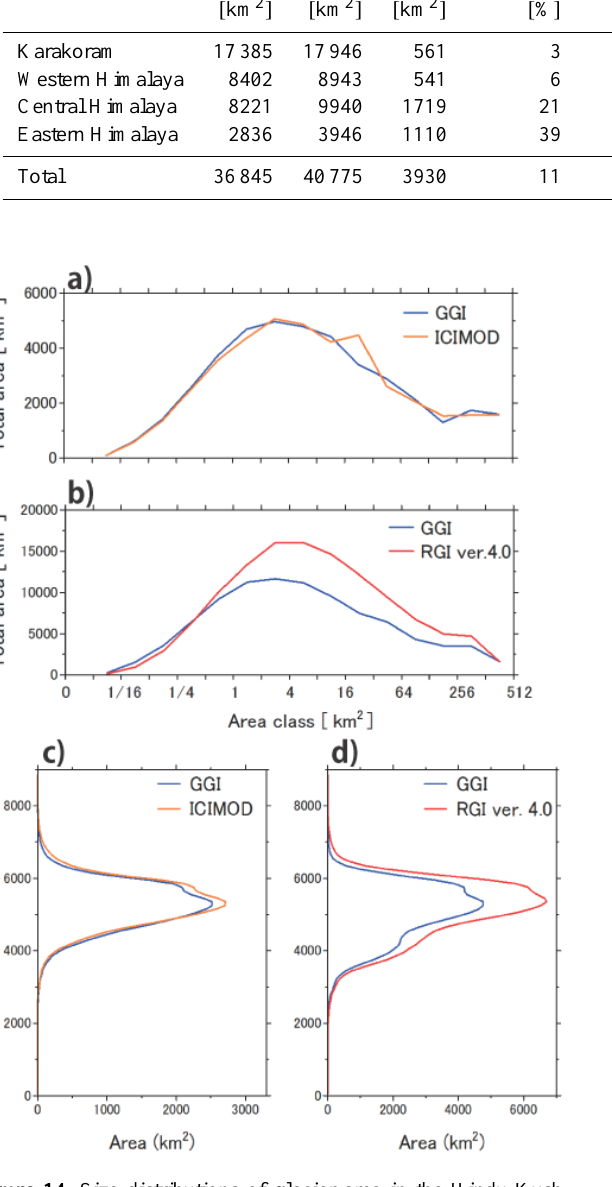
Figure 14. Size distributions of glacier area in the Hindu Kush– Himalaya range from the GGI and the ICIMOD inventories (a) , and in high-mountain Asia from the RGI and GGI (b) . Glacier hyp- sometries for the Hindu Kush–Himalaya range from GGI and ICI- MOD (c) and high-mountain Asia derived from the GGI and RGI in 100m bins (d) . Only glaciers > 0.05km 2 in area are included in the calculation for each inventory. All hypsometries were calculated using the